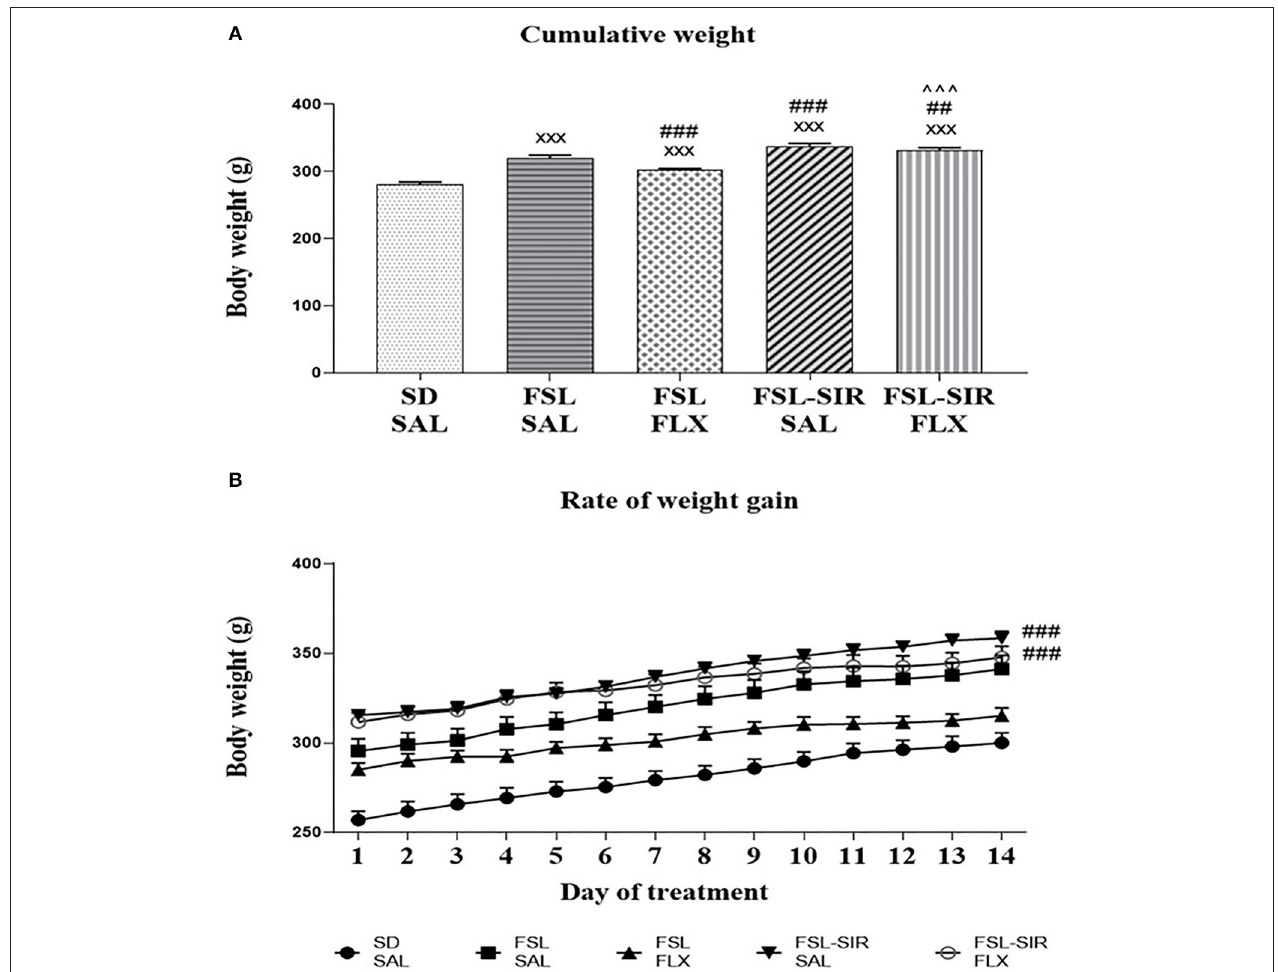
FIGURE 2 | (A) Mean cumulative weight in SD, FSL, and FSL-SIR rats following treatment with SAL or FLX. xxx p < 0.0001 vs. SD-SAL; ### p < 0.0001, ## p < 0.01 vs. FSL-SAL; ∧∧∧ p < 0.0001 vs. FSL-FLX. (B) Rate of weight gain during the treatment period. ### p < 0.0001 vs. FSL-SAL. Data are represented as the mean of 12 animals. Data were analysed using two-way ANOVA followed by Bonferroni post hoc test. Data are presented as mean ± SEM. Precise p –values are presented in the text. FSL, Flinders’ Sensitive Line; FLX, fluoxetine; SAL, saline; SD, Sprague-Dawley; SIR, social isolation rearing.